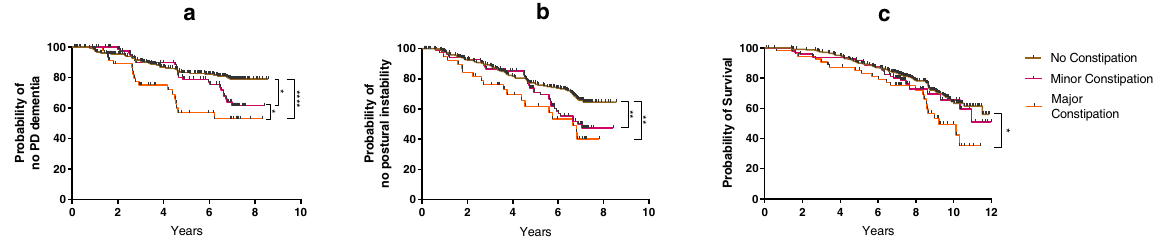
Fig. 1 Survival analysis for major outcomes of Parkinson ’ s disease according to constipation severity. Kaplan – Meier survival analysis for dementia ( a ), postural instability ( b ) and mortality ( c ) in groups strati fi ed by constipation severity. (*, **, **** denote p ≤ 0.05, p ≤ 0.01, p ≤ 0.0001, respectively, log-rank